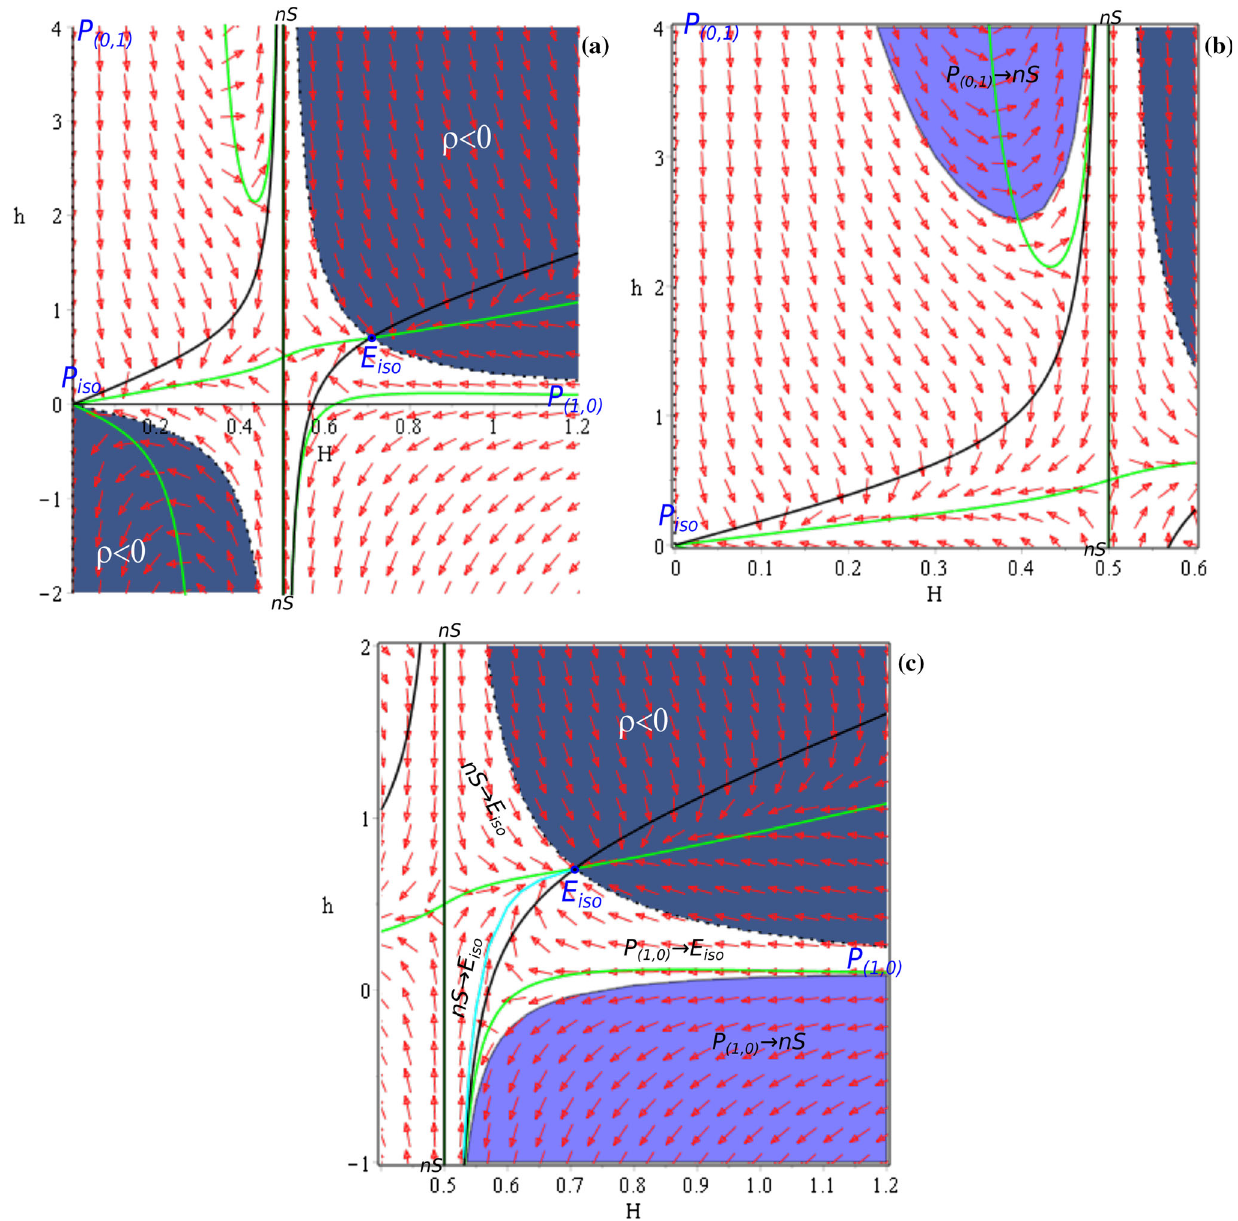
Fig. 2 Phase portraits for D = 1 α < 0, ω < 0 case: general view on a , regimes for H < H ns on b and regimes for H > H ns on c . Blue areas correspond to the initial conditions associated with specific regimes; light blue lines also separate the initial conditions associated